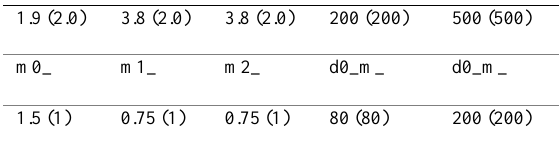
Table 3. Parameters of the propagation environment model Nakagami.